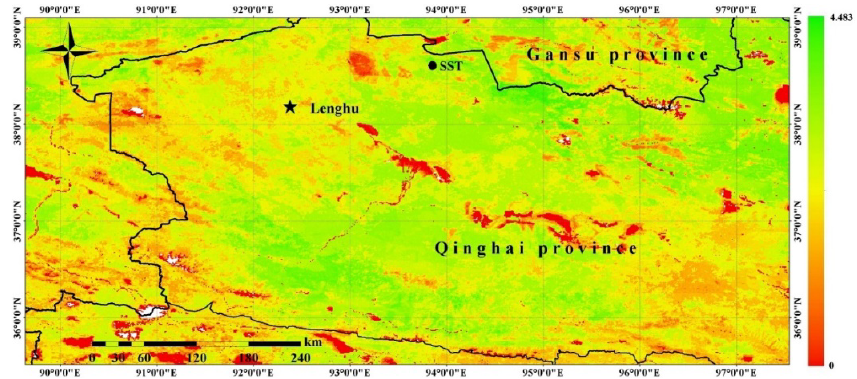
Fig. 6. Environmental suitability of optical astronomical observation in the study